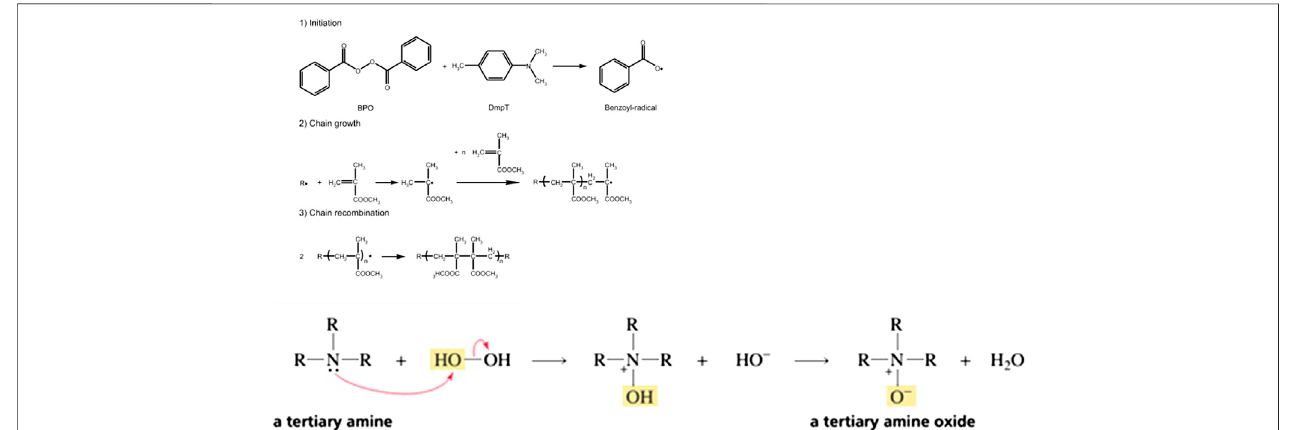
FIGURE 2 | Progression of initiation of amine